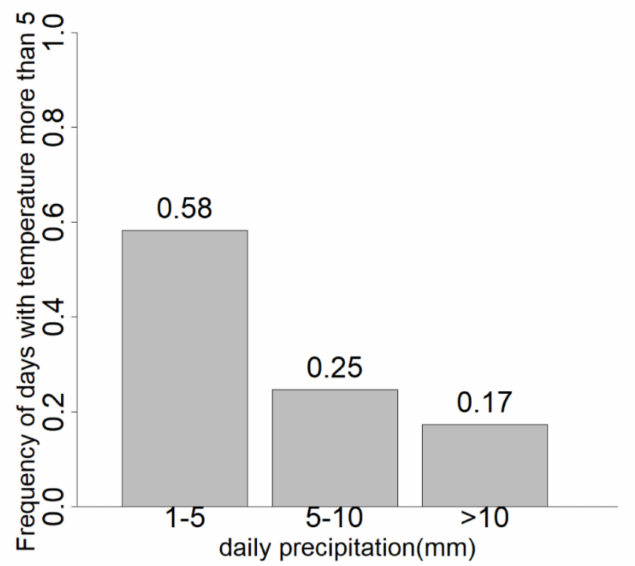
Figure A4. The relationship between daily precipitation and the distribution of days with tempera- tures greater than 5 ◦